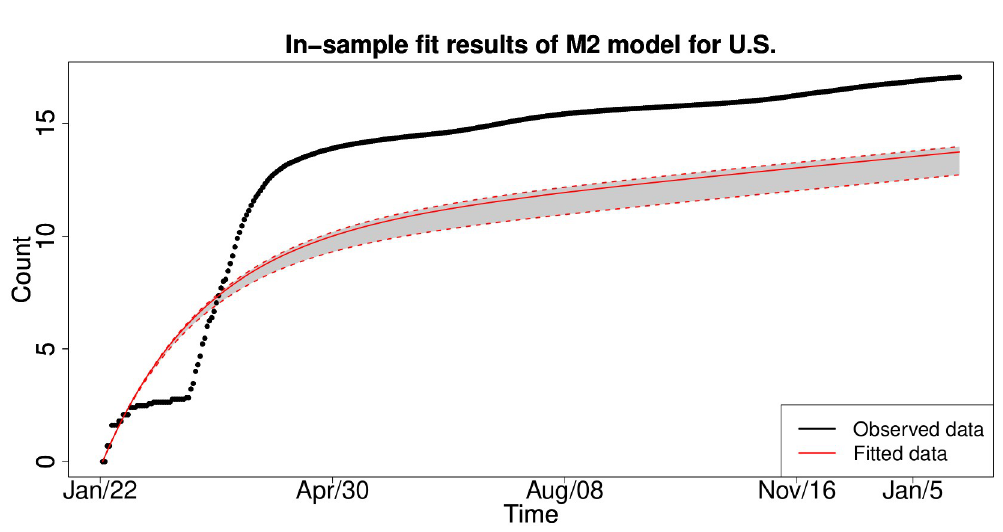
Fig 12. In-sample fit results for the US for the period January 2020—January 2021. In-sample fitted plot (y-axis in log scale) for the US by Model 2 (baseline) (January 2020—January 2021).